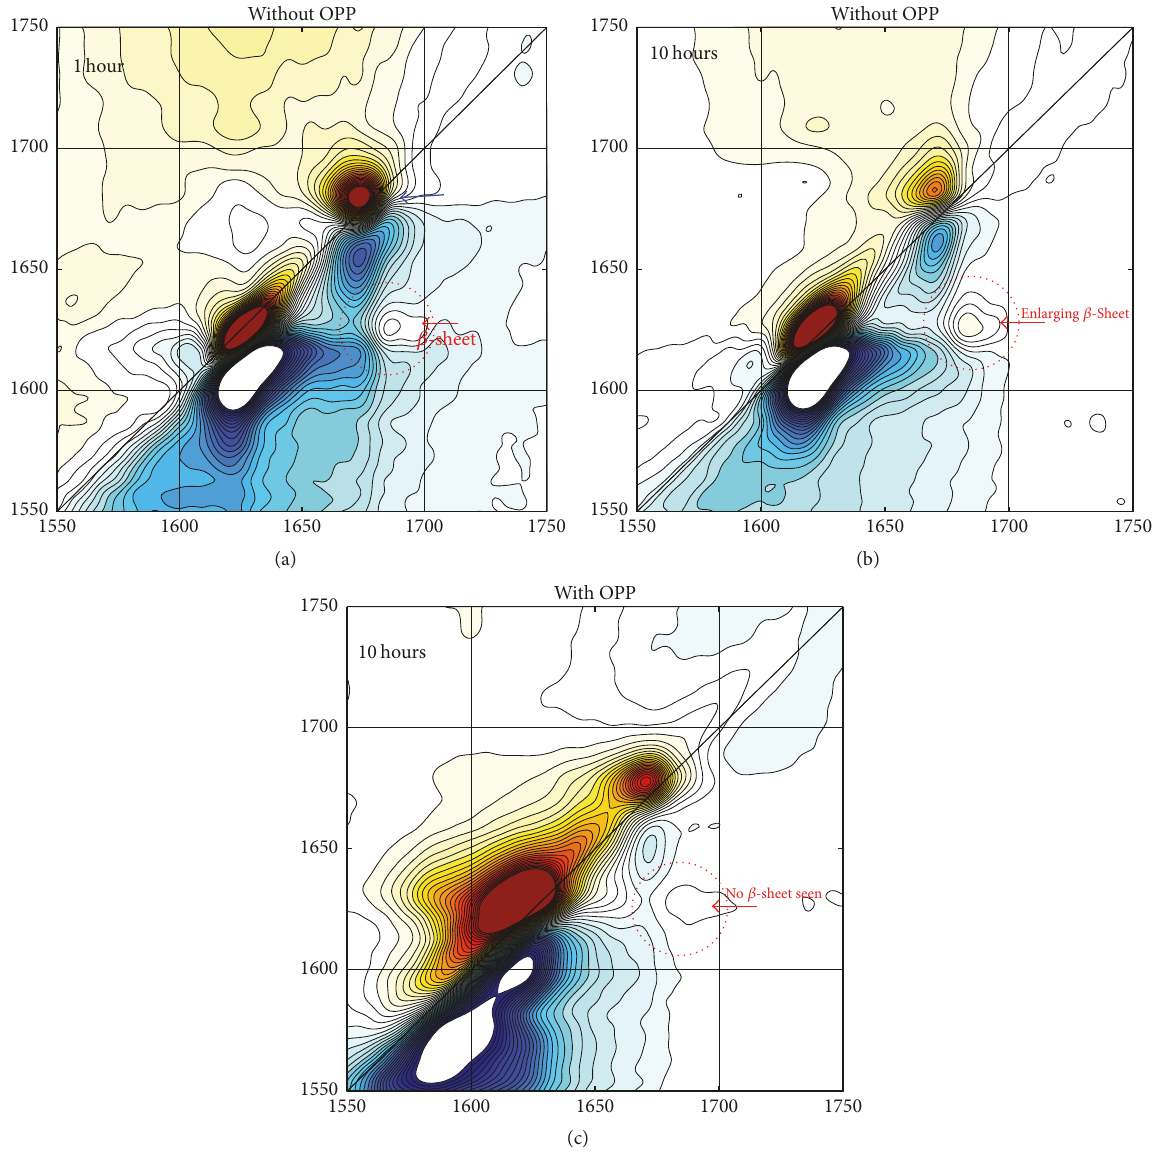
Figure 5: Amide-I two-dimensional correlation spectra of the A 𝛽 42 samples incubated at 37 ∘ C. without OPP at 1-hour (a) and at 10-hour (b) incubation. A 𝛽 42 sample incubated at 37 ∘ C. with 10 𝜇 g/ml OPP at 10 hours (c). The diagonal peak at 1672 cm −1 , indicated by a blue arrow, is due to tetrafluoroacetic acid (TFA) present in the sample. The cross-peak near [𝜔1,𝜔3] = [1620, 1680] cm −1